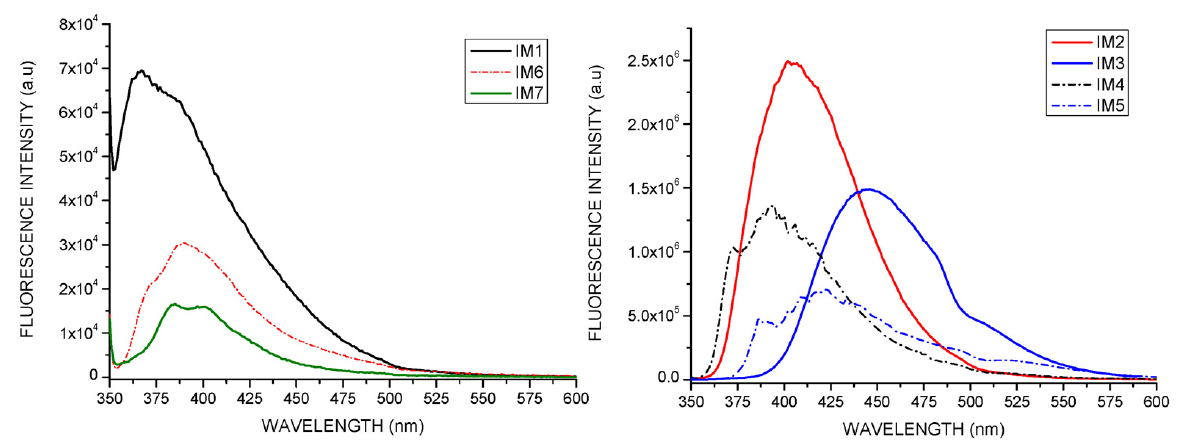
Figure 2. Fluorescence emission spectra of the synthesized naphth[1,2 ‐ d ]imidazoles ( λ Exc 345 nm).